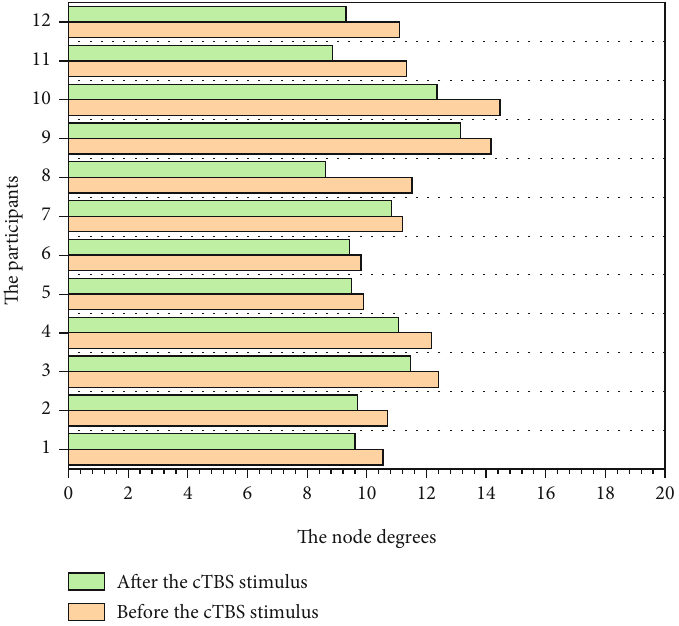
Figure 4: Network node degree before and after cTBS stimulation.